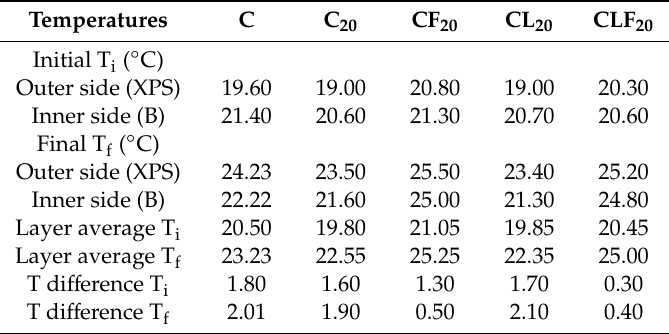
Table 3. Temperatures on both sides of the PCM cement-lime mortar layer measured inside the enclosure during the heating cycle (from 15 ◦ C to 30 ◦